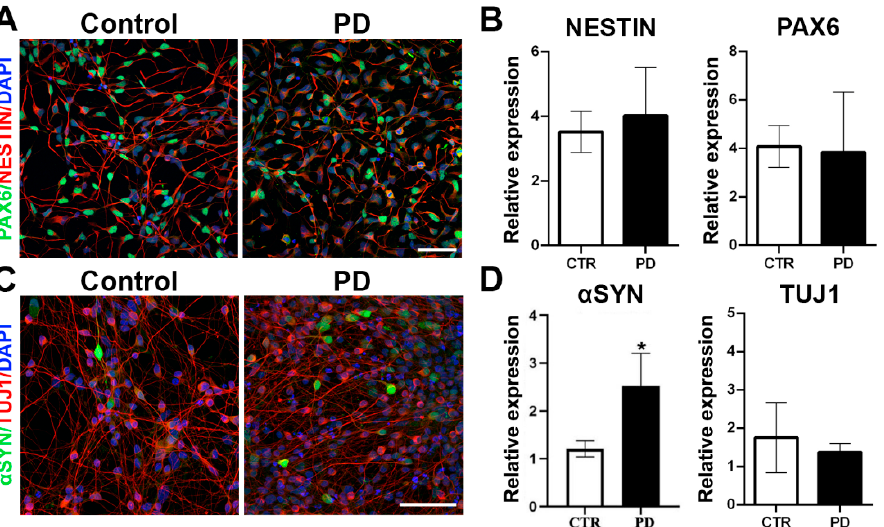
Figure 1. NPC characterization and spontaneous neuronal differentiation. ( A ). Immunostaining of CTR and PD iPSC-derived NPCs for PAX6 (green) and NESTIN (red). Cell nuclei are counterstained with DAPI (blue). Scale bar, 50 µm. ( B ). RT-qPCR analysis of NESTIN and PAX6 mRNA expression normalized to GAPDH levels. Data represent mean ± SEM (n = 3). ( C ). Immunostaining for α -synuclein ( α SYN; green) and β III-tubulin (TUJ1; red) in CTR and PD iPSC-derived neurons at 25 DIV. Cell nuclei are counterstained with DAPI (blue). Scale bar, 50 µm. ( D ). RT-qPCR analysis of mRNA expression for α -synuclein ( α SYN) and β III-tubulin (TUJ1). Data represent mean ± SEM (n = 3, * p < 0.05).